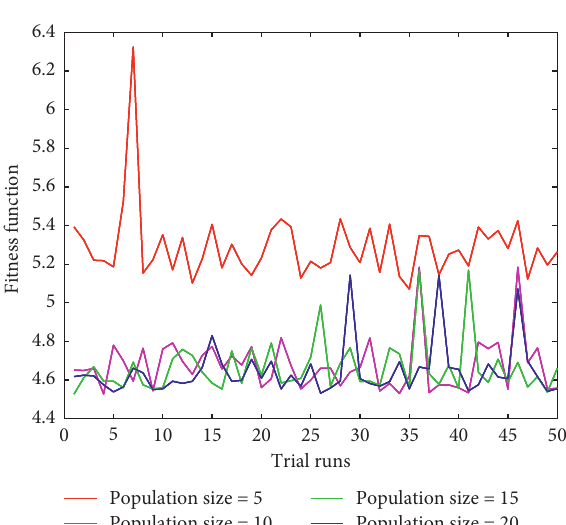
Figure 1: The impact of population size on obtained fitness values of 50 trial runs.